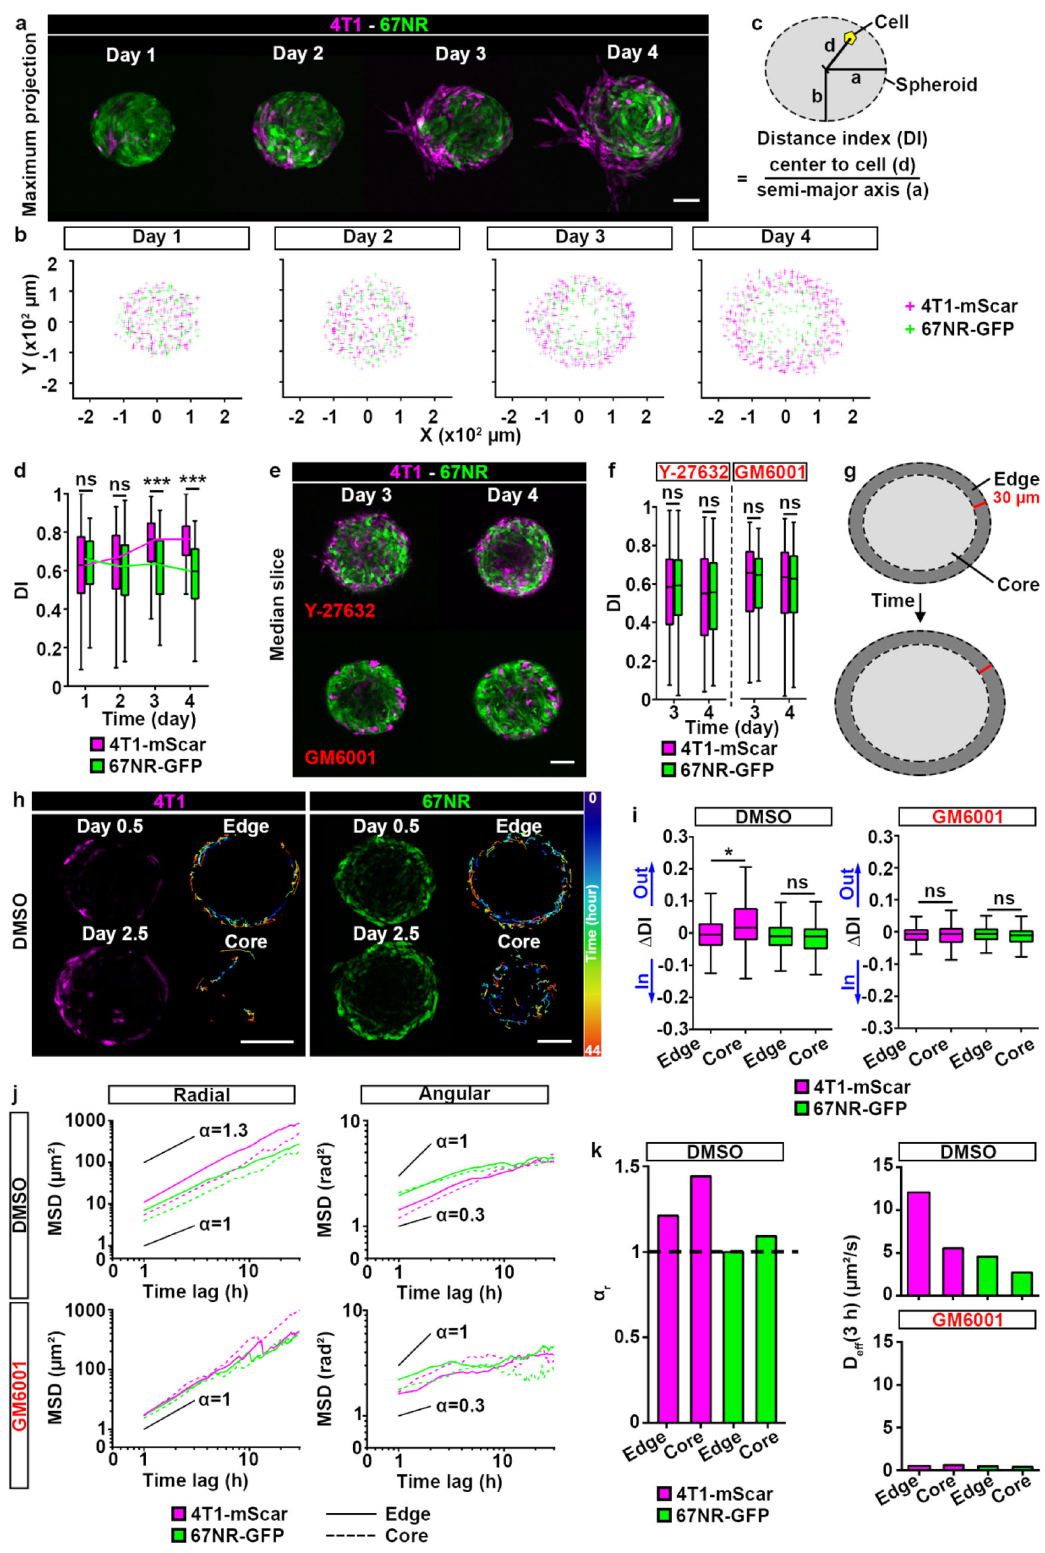
was also present in individual spheroids (Fig. S4e). These data revealed that, over the course of 3 days, cells reorganized from a random distribution to spheroids with 4T1 cells populating the interface and 67NR cells located in the spheroid core. On days 4-6, cell sorting of 4T1 and 67NR cells was followed by the invasion (Fig.